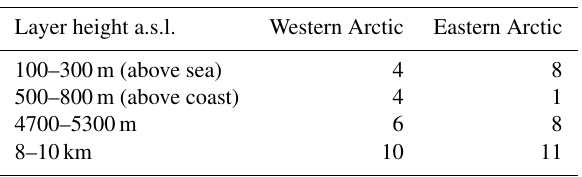
Table 5. Statistics of samples over different regions of the Russian Arctic in September